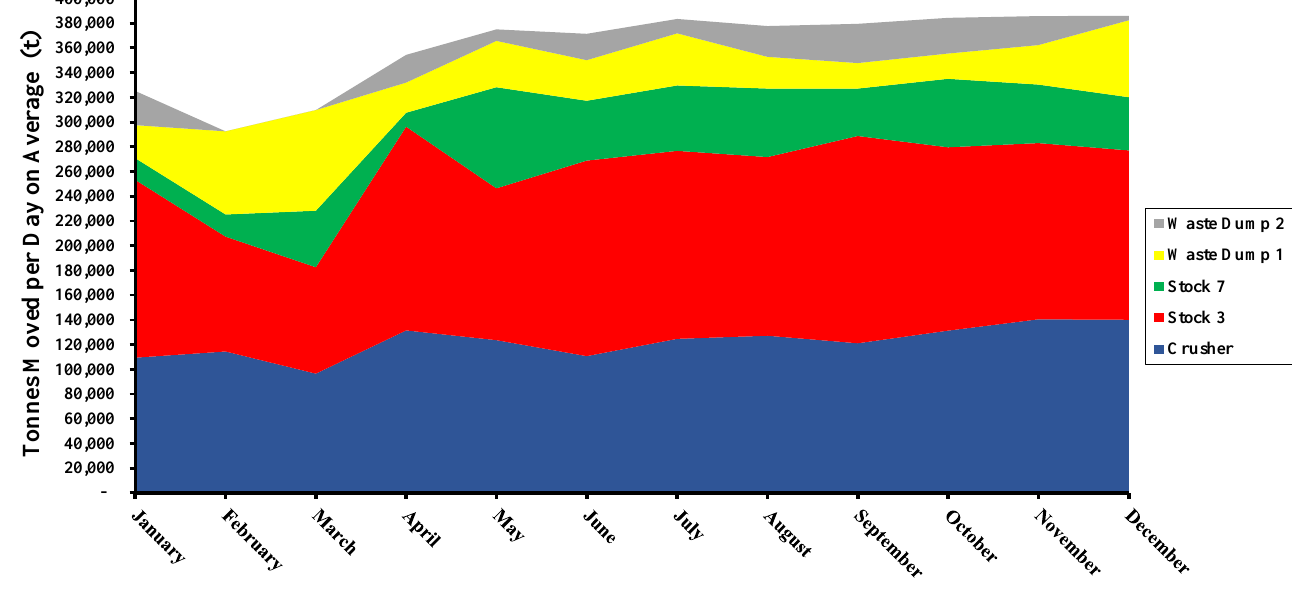
Figure 9. Tons moved per day on average during 2023.